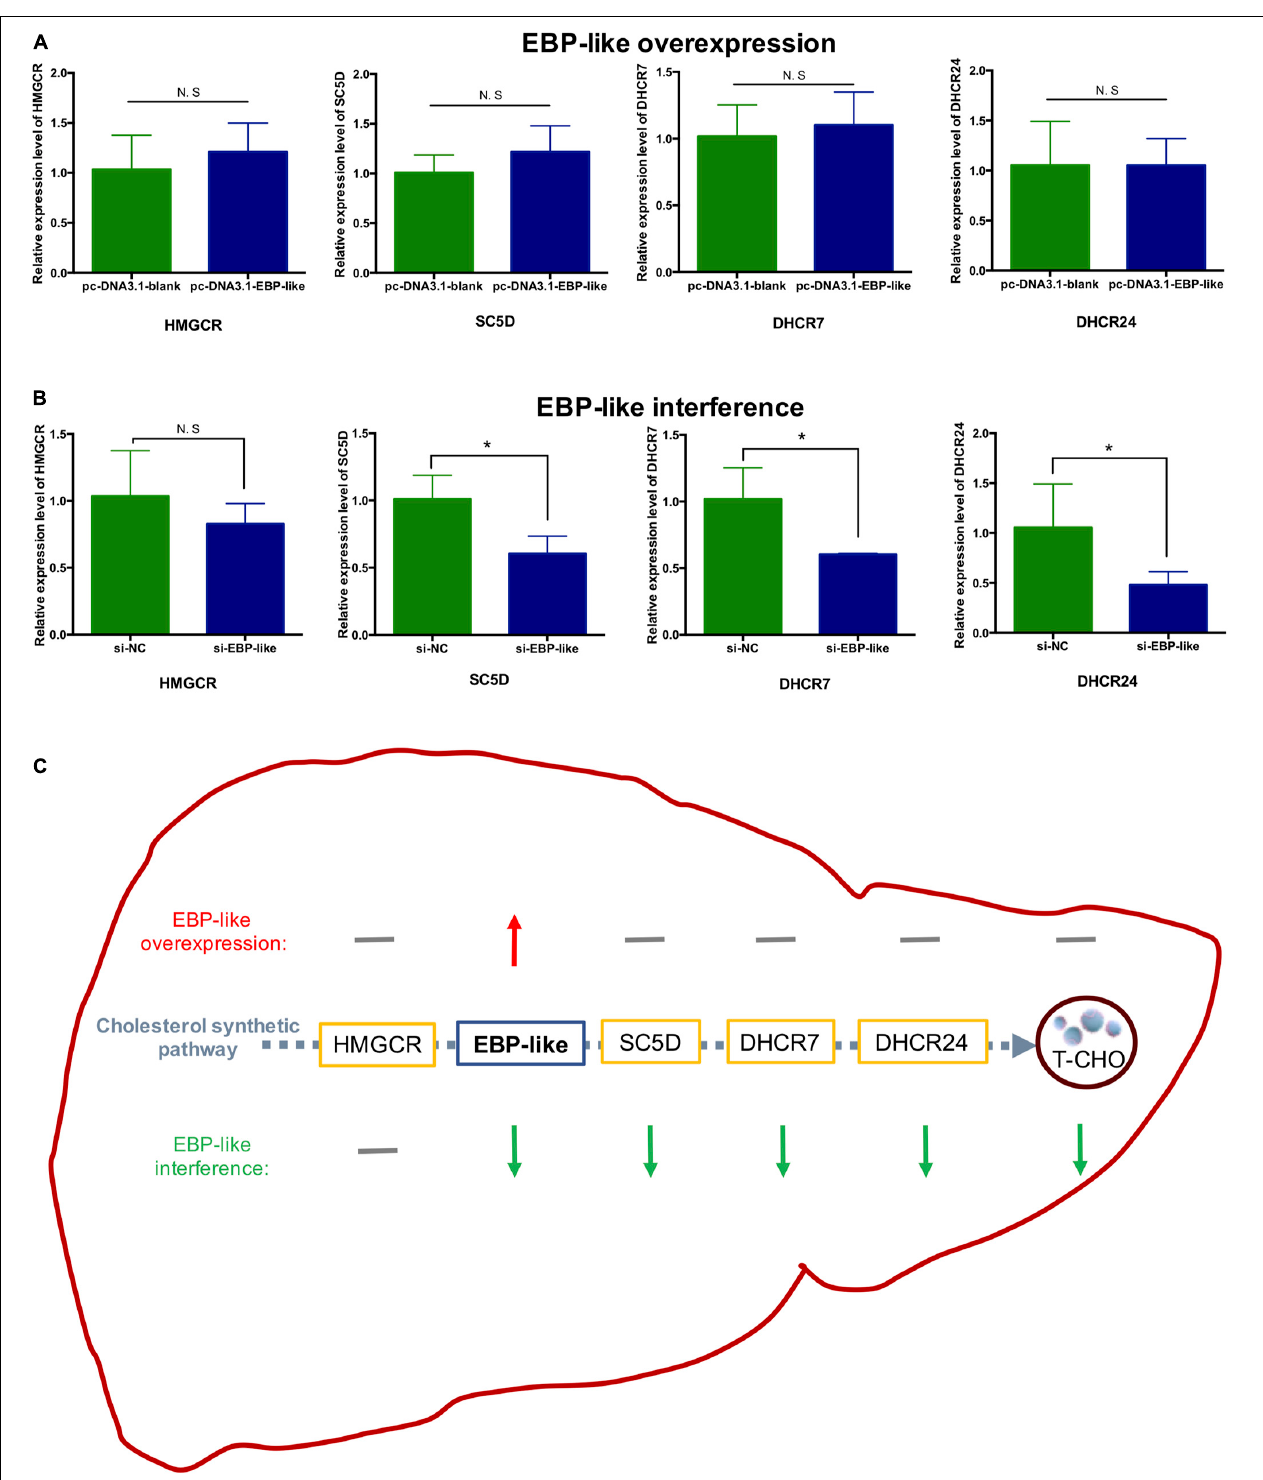
FIGURE 7 | Effect of EBP-like on the expression level of genes related to cholesterol synthesis. (A) Effect of EBP-like overexpression on the expressions of HMGCR , SC5D , DHCR7 , and DHCR24 . (B) Effect of EBP-like interference on the expressions of HMGCR , SC5D , DHCR7 , and DHCR24 . (C) Effects of EBP-like overexpression and interference on the expressions of cholesterol synthesis pathway genes and the liver intracellular cholesterol (T-CHO) level. Note: all data are presented as mean ± SD ( n = 4–6). * P < 0.05. Red upward arrow represents for upregulated; green downward arrow represents for downregulated; gray horizontal line represents for no significant